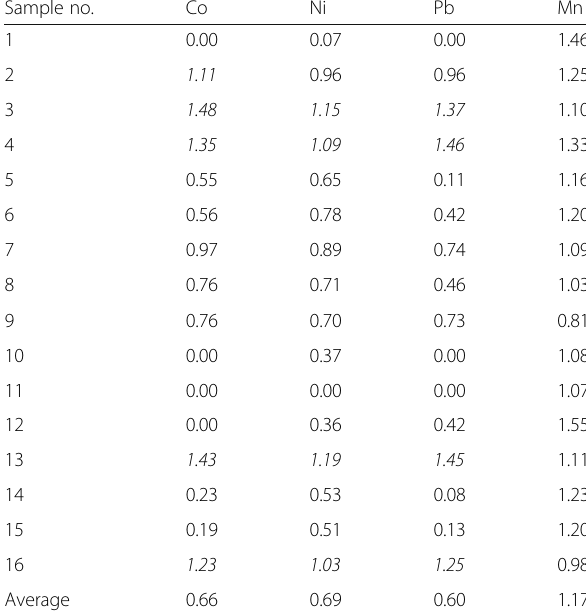
Table 2 Contamination factor (CF) of the studied elements (italic numbers refer to the moderate contaminated samples) Sample no.